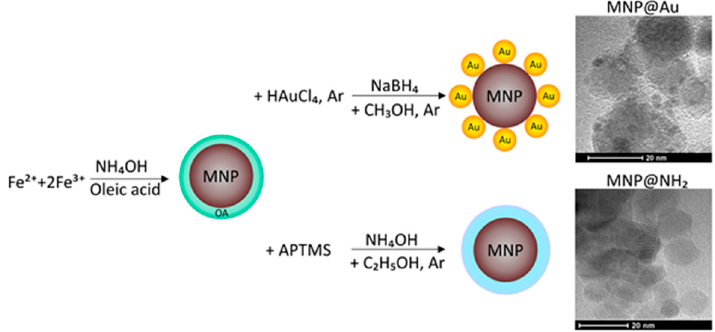
Figure 8. Synthesis and morphology of magnetic nanoparticles coated by gold (MNP@Au), and with a terminal amine group (MNP@NH 2 ) attached to their surface.